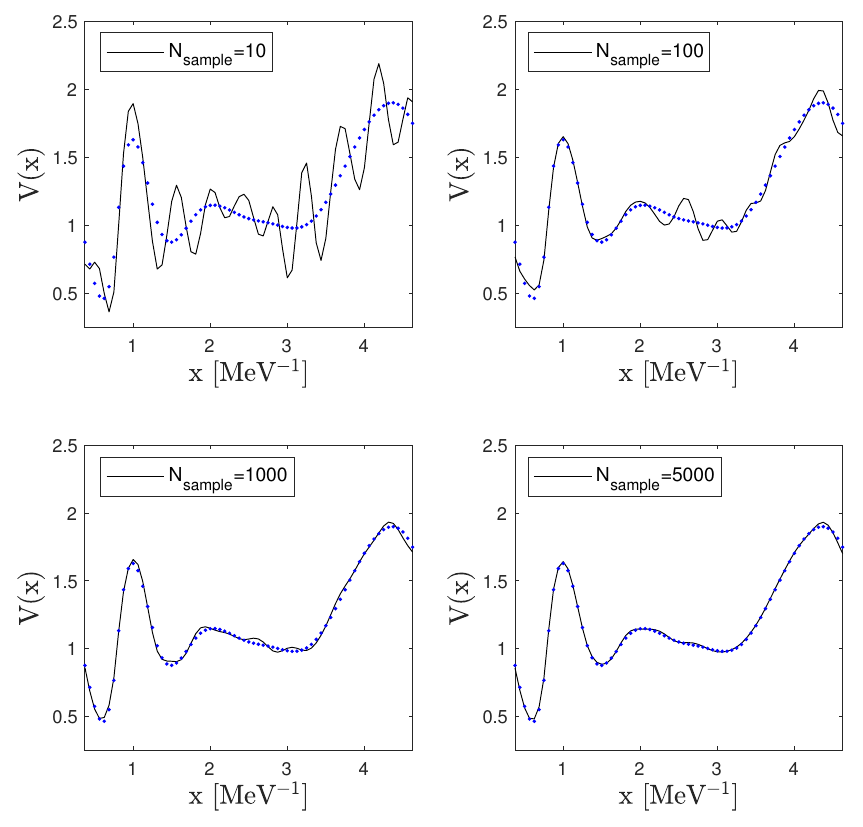
Figure 15. Averaging the output of the identified Volterra model to noisy inputs. The black lines are the outputs of the Volterra model, while the blue dots are the true potentials that correspond to the noiseless